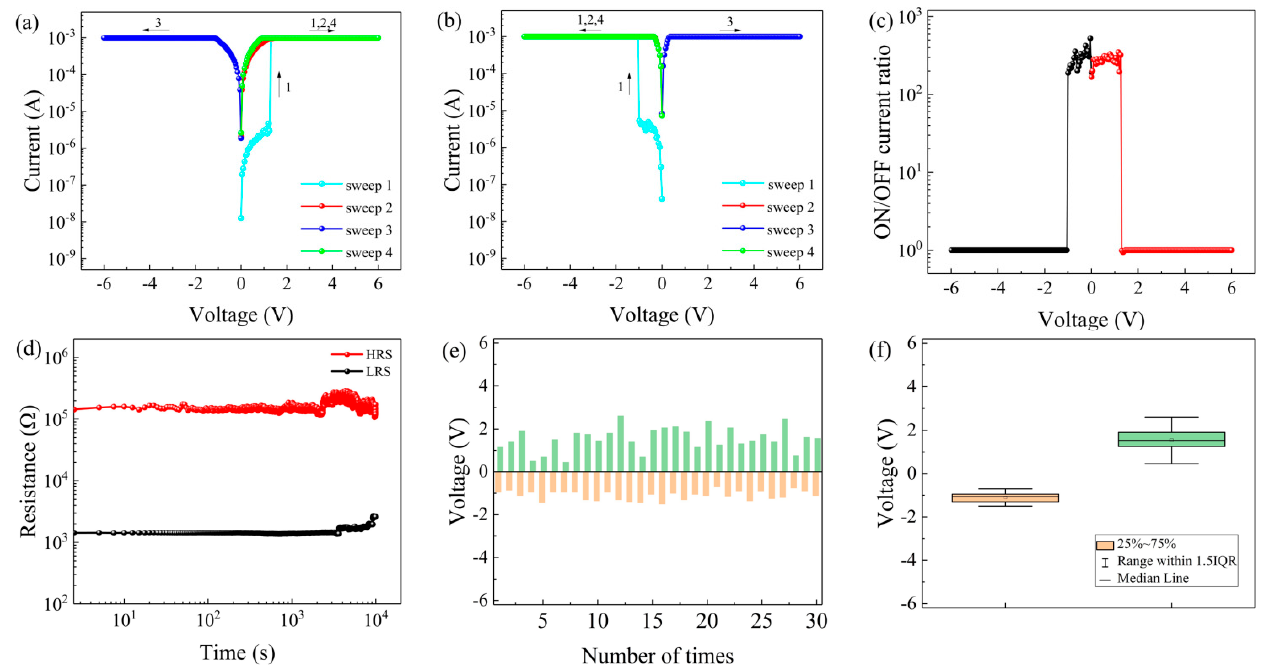
Figure 3. Current-voltage characteristics of the Al/TH/ITO/PET device: ( a ) initially applied negative voltage, ( b ) initially applied positive voltage, ( c ) ON/OFF current ratio of the device, ( d ) retention time of the device, ( e ) threshold voltage histogram and ( f ) threshold voltage statistics graph.